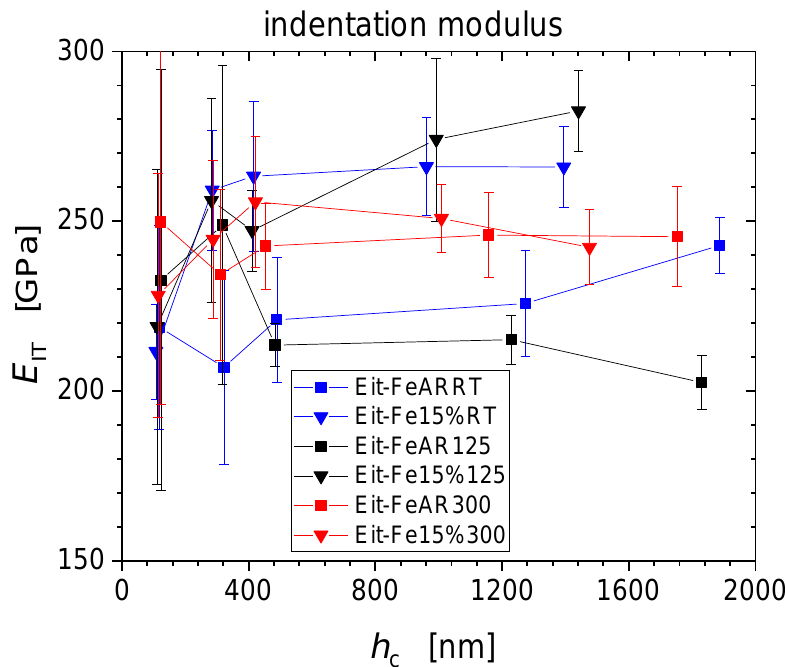
Figure 4. Indentation modulus values of un-strained and 15% pre-strained Fe as measured by nanoindentation.